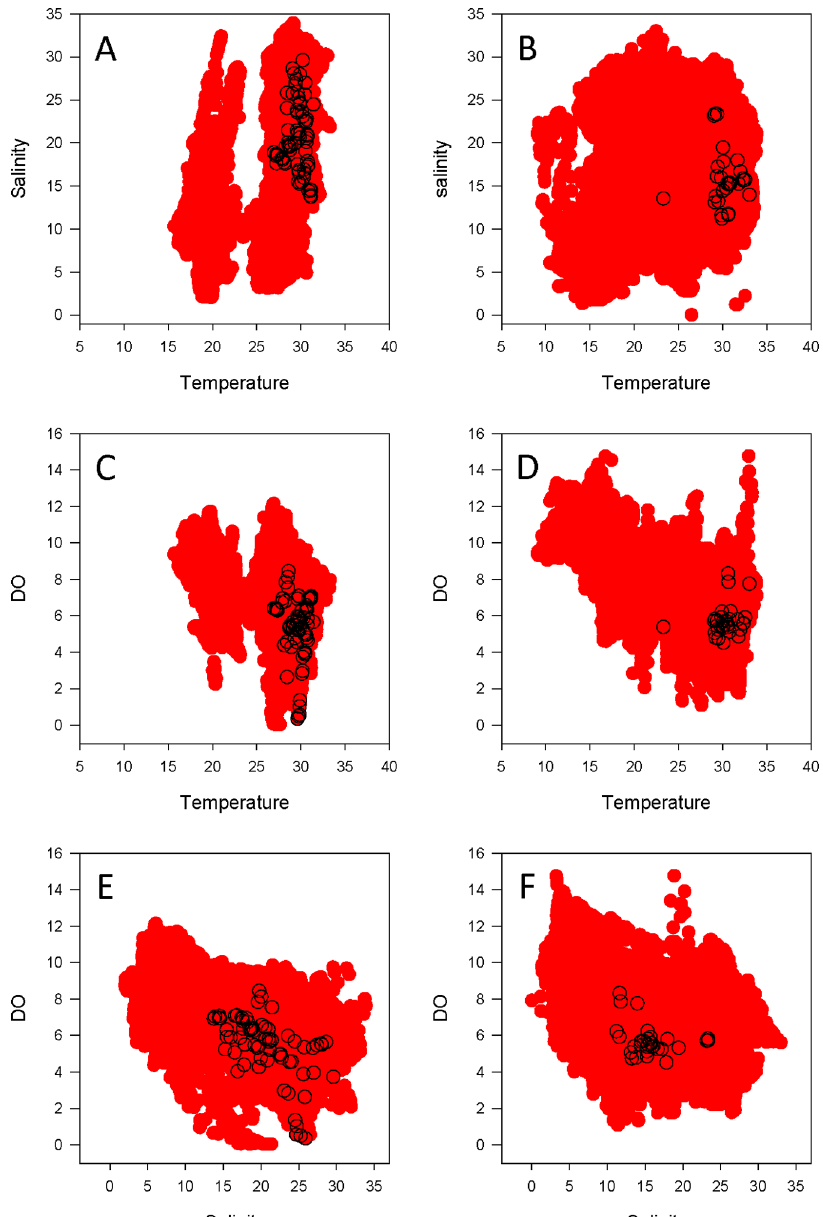
Figure 6. Bull shark dynamic habitat use in the lower bay. Dynamic habitat use of the lower Mobile Bay by bull sharks acoustically detected in 2009 (left column) and 2010 (right column): Temperature vs. Salinity (A, B), Temperature vs. Dissolved Oxygen (C, D), and Salinity vs. Dissolved Oxygen (E, F) are shown. Areas in red indicate the available dynamic habitat (data from the NEP mooring stations), and open circles indicate the presence of telemetered bull